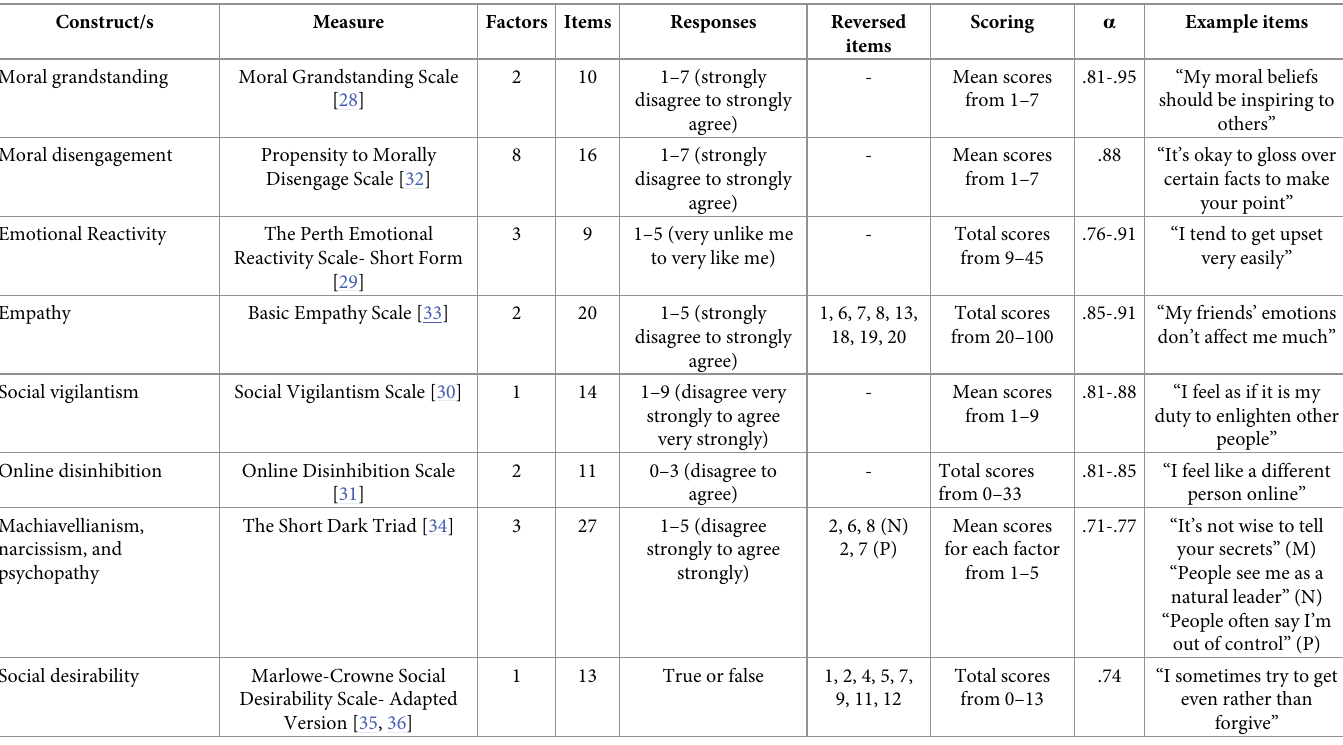
Table 1. Predictor and control variable